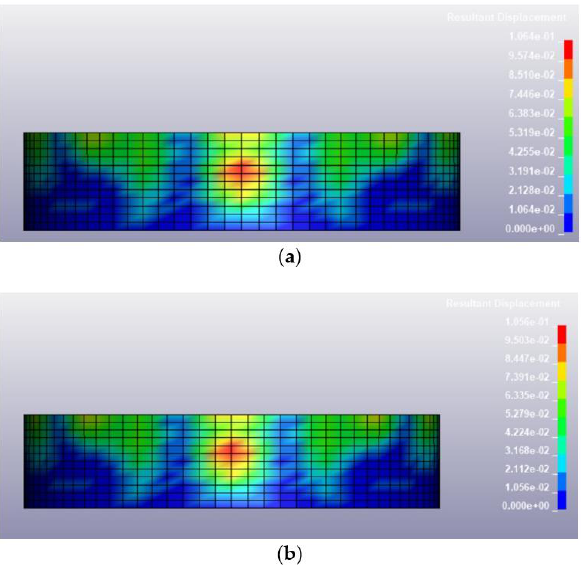
Figure 12. Deformed shape of the tank under blast intensity of 380 kg TNT equivalent mass 25 m away, ( a ) 100% fill level and ( b ) 0% fill level.